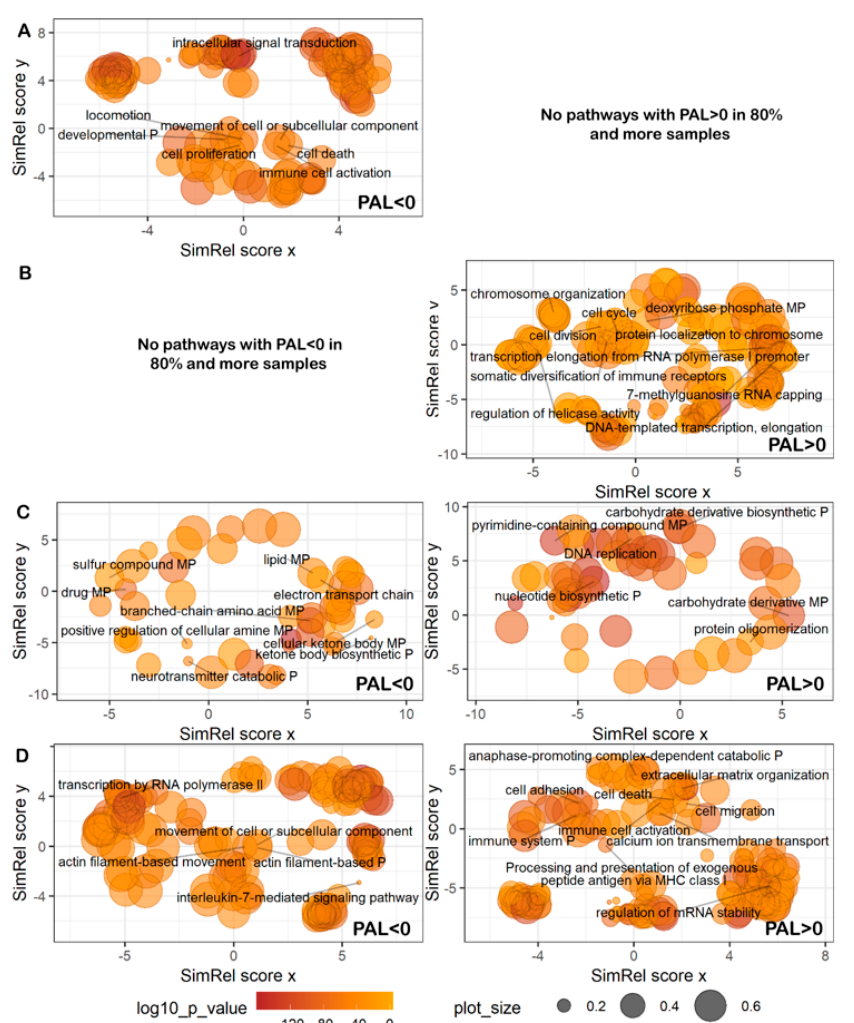
Figure 9. Representation of Gene Ontology annotations for genes from most strongly downregulated (PAL < 0; left) and upregulated (PAL > 0; right) ( A ) cytoskeleton, ( B ) DNA repair, ( C ) metabolic, ( D ) signaling pathways. Bubble size indicates the frequency of the Gene Ontology term in the underlying GOA database [54] (bubbles corresponding to more general terms are shown larger). “P” stands for process, “MP”—for metabolic process. Too general and non-informative gene ontology terms are not defined. No cytoskeleton pathways with PAL < 0 and DNA repair pathways with PAL > 0 could be identified in 80% and more